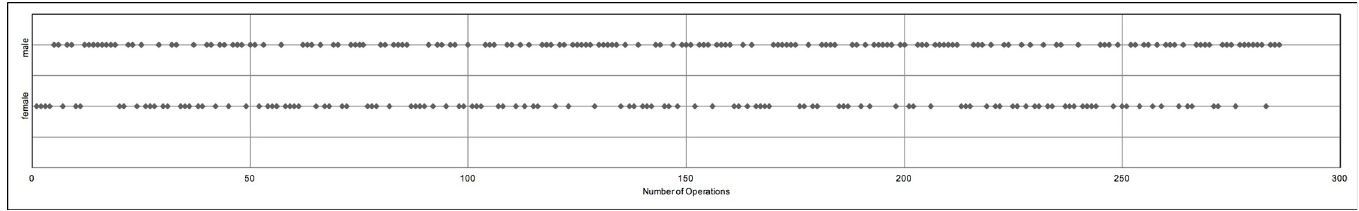
Fig 13. Graphical illustration of gender distribution over time. The number of operations over time are displayed on the x-axis, with gender (male/female) on the y- axis. Each datapoint represents one operation.